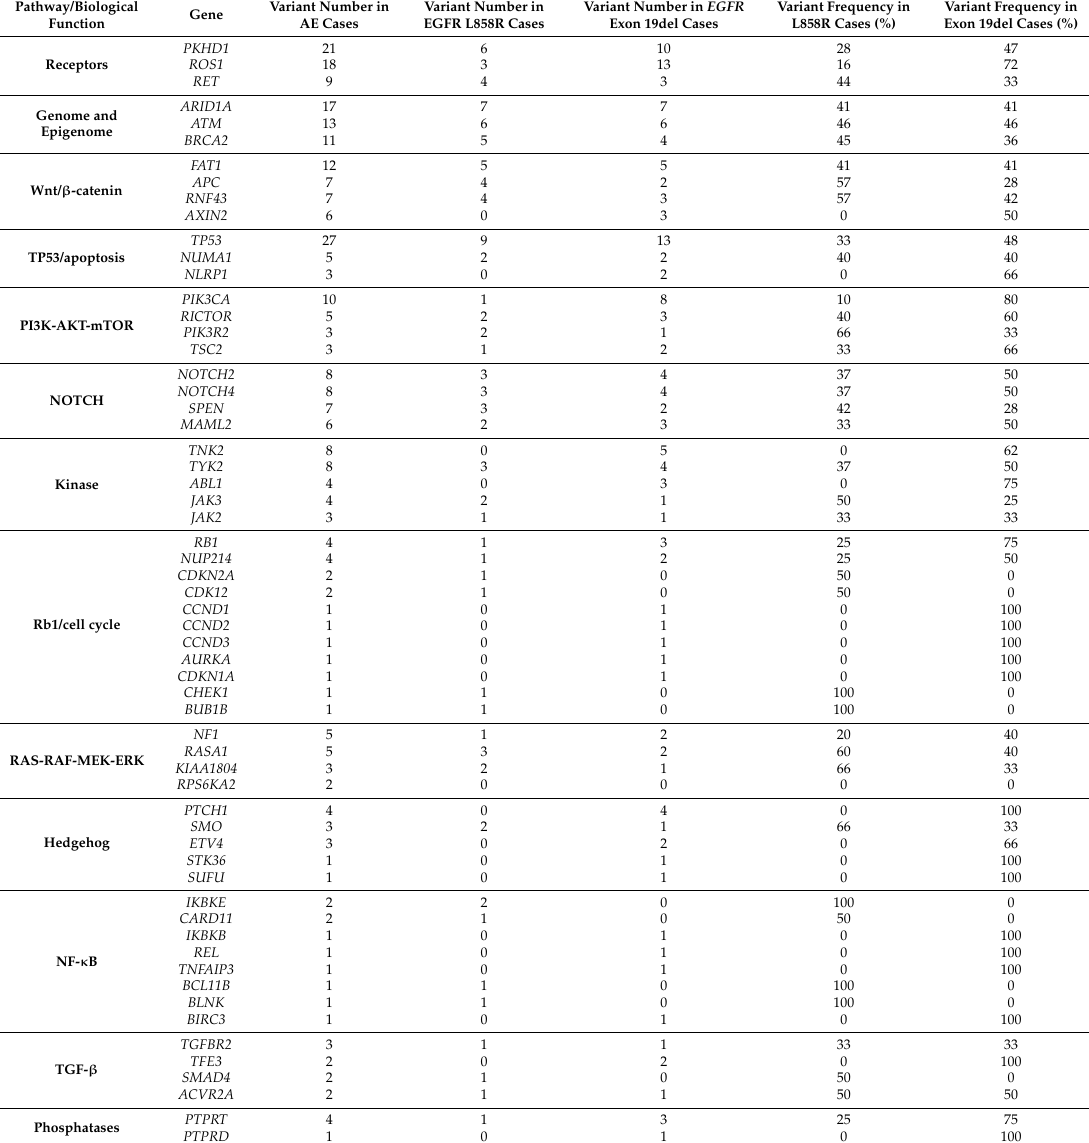
Table 5. Mutation Distribution of Top Three Mutated Genes between EGFR L858R and EGFR exon